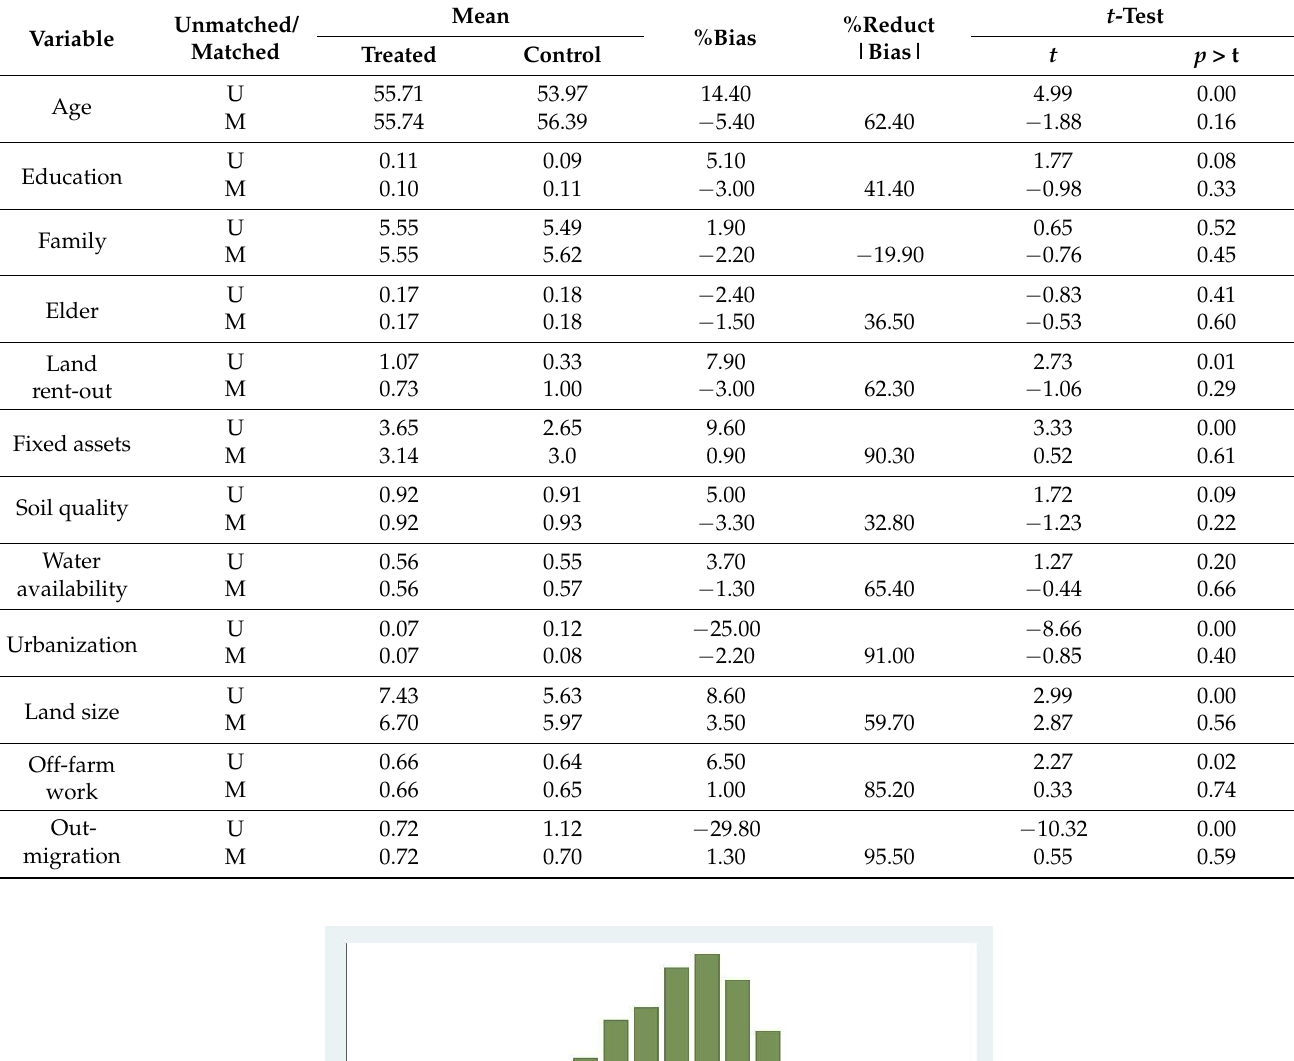
Table 3. PSM validity test.